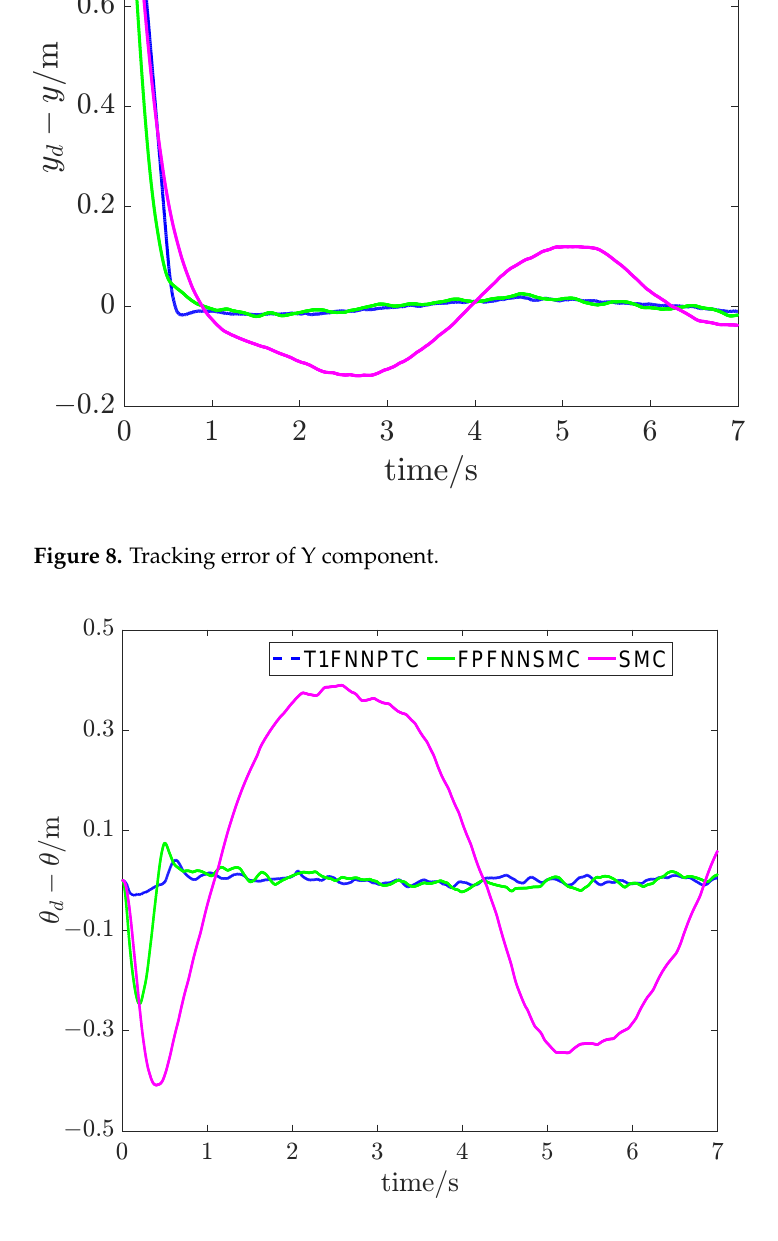
Figure 9. Tracking error of θ